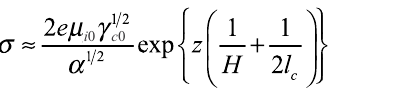
=2×10 2 a 0 =1.5×10 3 a 0 of ion pro- r 0 exp( z / z ) is 0 0